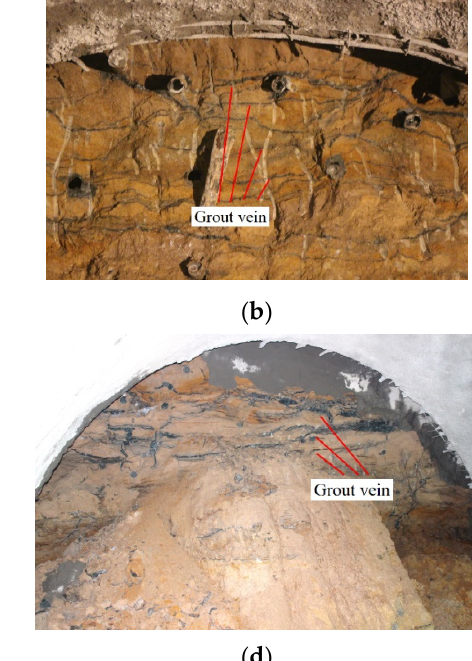
Figure 5. Typical grout veins in sand grouting projects of Qingdao metro line. ( a ) Beer-miao run- ning tunnel in Qingdao metro line 2. ( b ) Shilaoren station in Qingdao metro line 2. ( c ) Taishan station in Qingdao metro line 4. ( d ) Jia-ling running tunnel in Qingdao metro line 13.